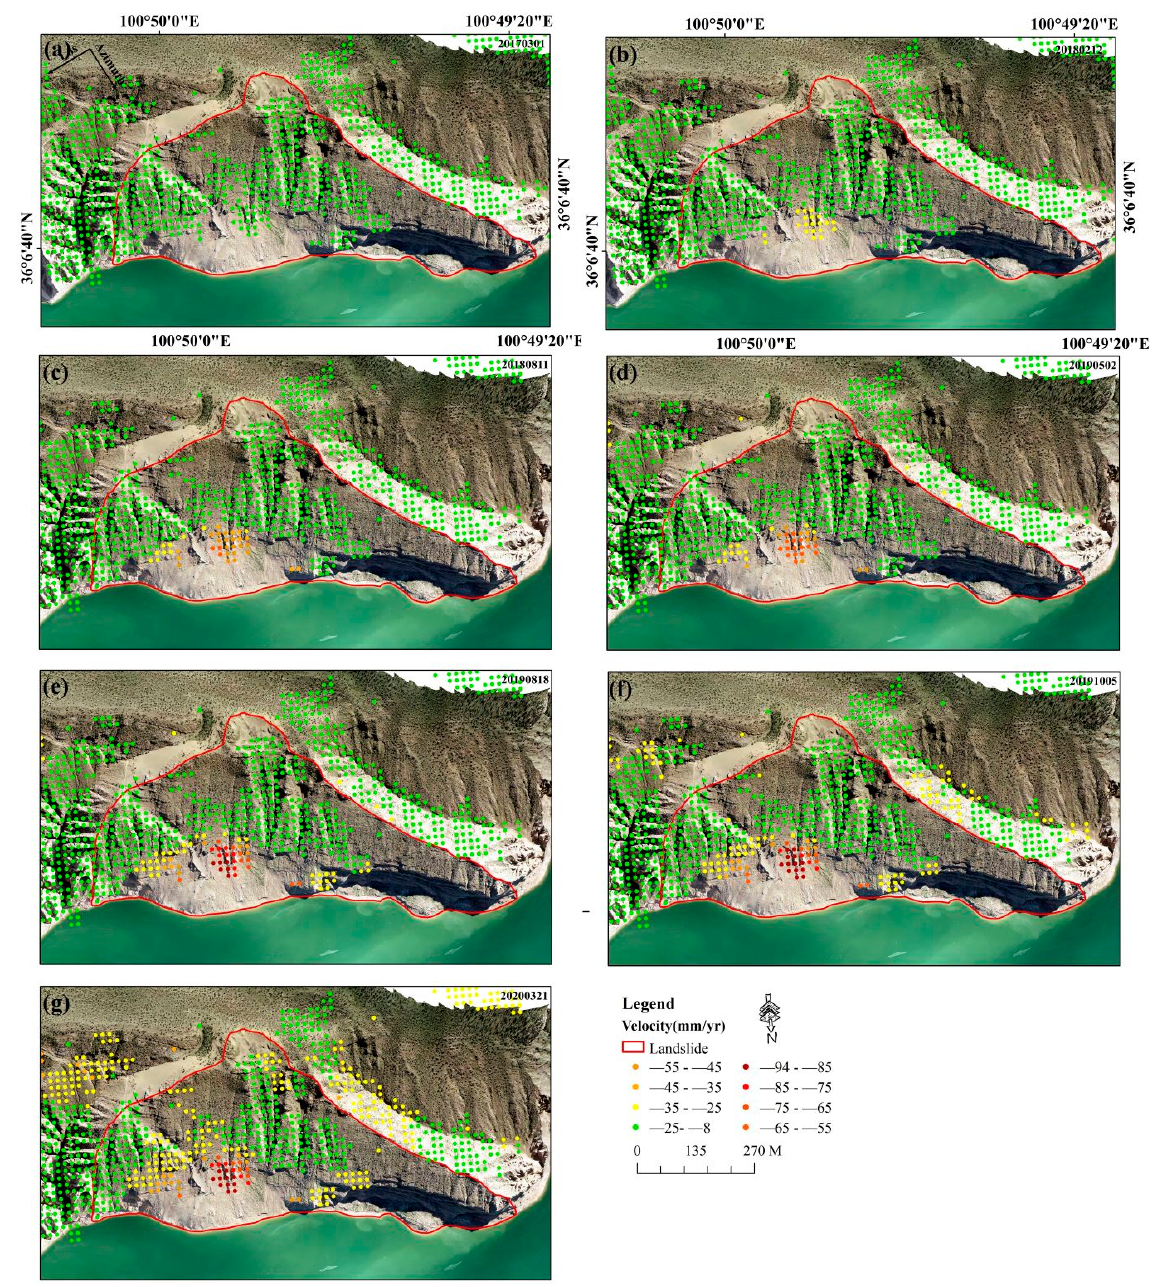
Figure 13. Spatial deformation characteristics of Chaxi landslide. ( a ) Cumulative displacement of Chaxi landslide on March 1, 2017, ( b ) Cumulative displacement of the Chaxi landslide on February 12, 2018, ( c ) Cumulative displacement of Chaxi landslide on August 11, 2018, ( d ) Cumulative dis- placement of Chaxi landslide on May 2, 2019, ( e ) Cumulative displacement of Chaxi landslide on August 18, 2019, ( f ) Cumulative displacement of Chaxi landslide on October 5, 2019, ( g ) Cumulative displacement of Chaxi landslide on March 21,